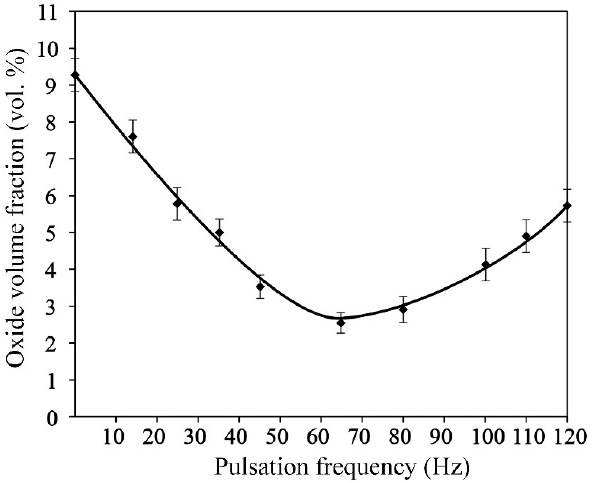
Figure 9. The effect of the pulsating frequency of the airflow upon the oxide volume fraction in the coating deposited with aluminum wire.